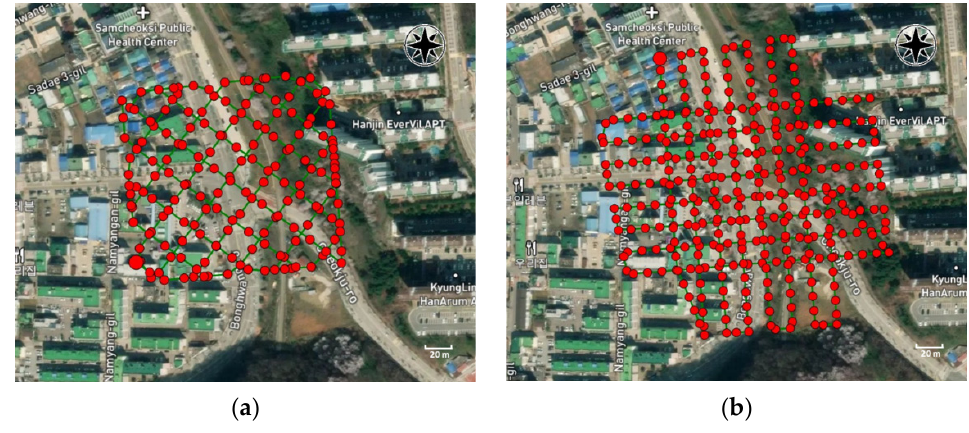
Figure 7. Camera angle for photographing UAV: ( a ) 90°; ( b ) 60°.